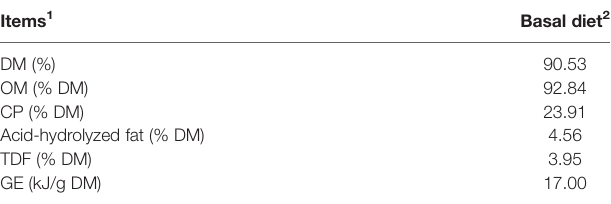
TABLE 2 | The chemical and energy composition of basal diet tested. Items